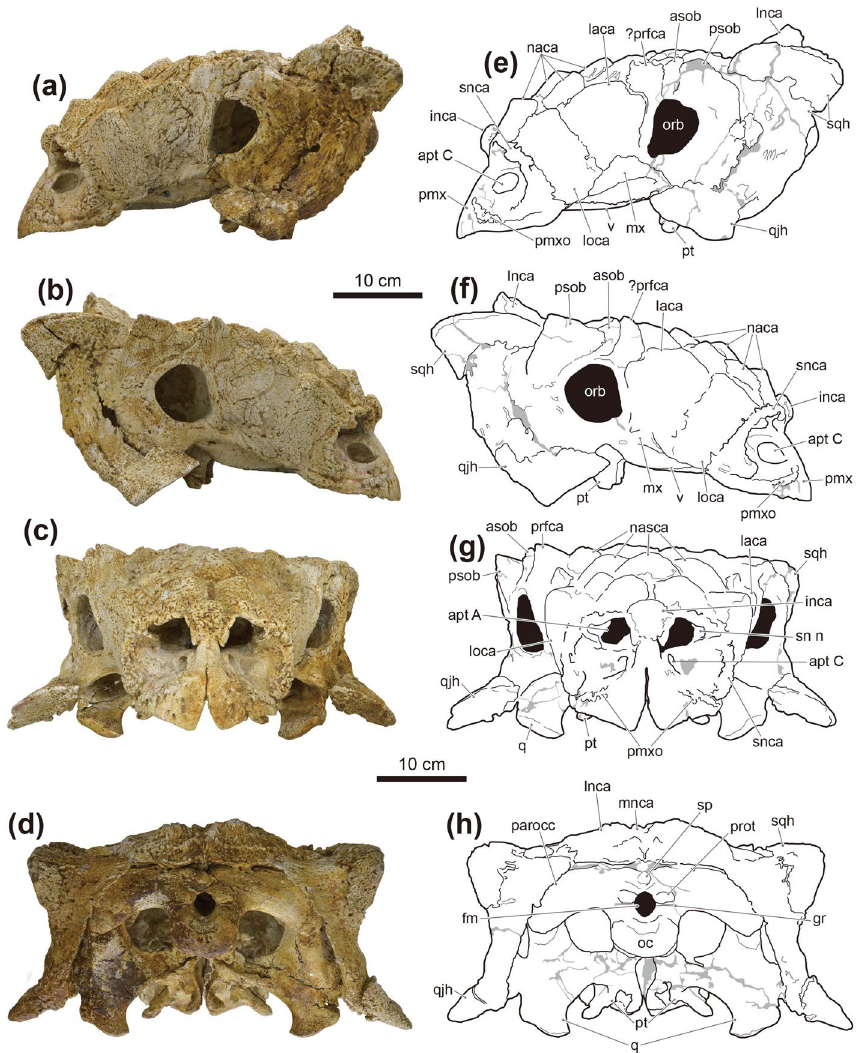
Figure 2. Photographs ( a – d ) and line drawings ( e – h ) of the skull of Tarchia tumanovae sp. nov. (MPC-D 100/1353). Photographs of the skull in ( a ) left lateral, ( b ) right lateral, ( c ) anterior, and ( d ) occipital views. Line drawings in ( e ) left lateral, ( f ) right lateral, ( g ) anterior, and ( h ) occipital views. Grey areas indicate damaged surfaces. apt A aperture A, apt C aperture C, asob anterior supraorbital caputegulum, fm foramen magnum, gr groove, inca internarial caputegulum, laca lacrimal caputegulum, lnca lateral nuchal caputegulum, loca loreal caputegulum, mnca medial nuchal caputegulum, mx maxilla, naca nasal caputegulum, oc occipital condyle, orb orbit, parocc paroccipital process, pmx premaxilla, pmxo premaxillary ornamentation, prfca prefrontal caputegulum, prot protuberance, psob posterior supraorbital caputegulum, pt pterygoid, q quadrate, qjh quadratojugal horn, sn n supranarial notch, snca supranarial caputegulum, sp small process between the foramen magnum and the nuchal shelf, sqh squamosal horn, v vomer. Adobe Illustrator CC (version 24.0.1, https:// www. adobe. com/ kr/ produ cts/ illus trator. html) was employed to produce ( e – h